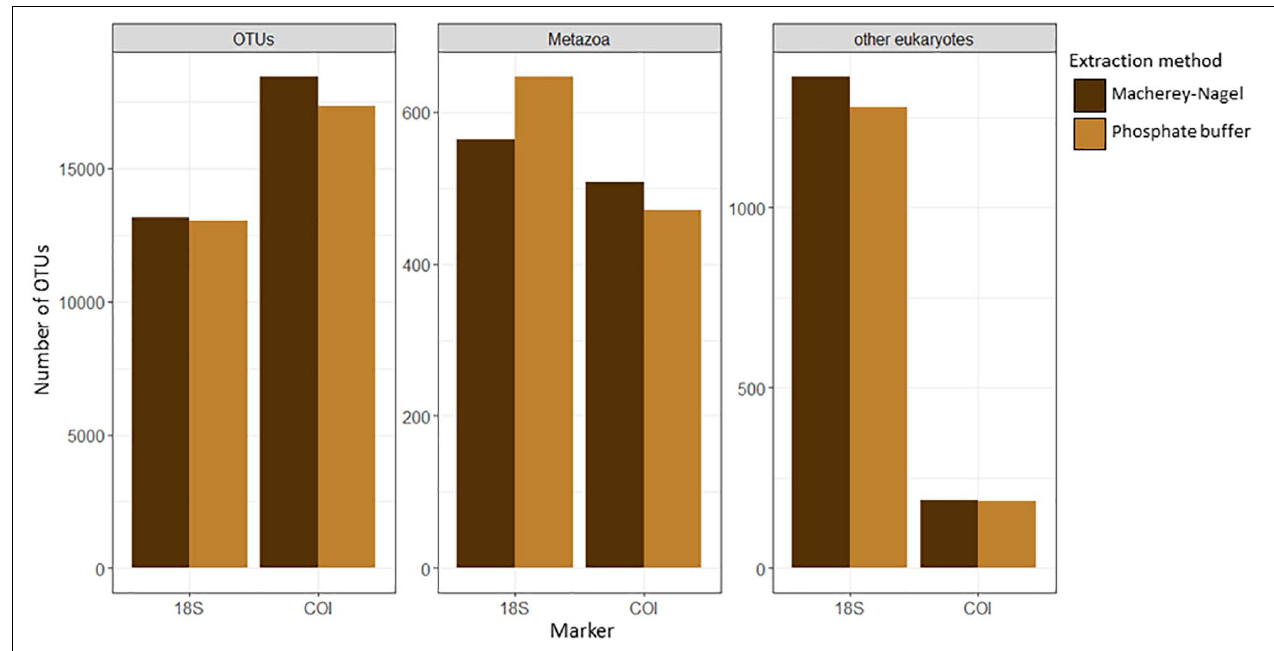
FIGURE 3 | Total number of OTUs and number of OTUs assigned (blastID ≥ 97%) to Metazoa and other eukaryotes (consisting of Fungi, Chromista, Protozoa, Plantae) for the two extraction methods and markers used (18S and